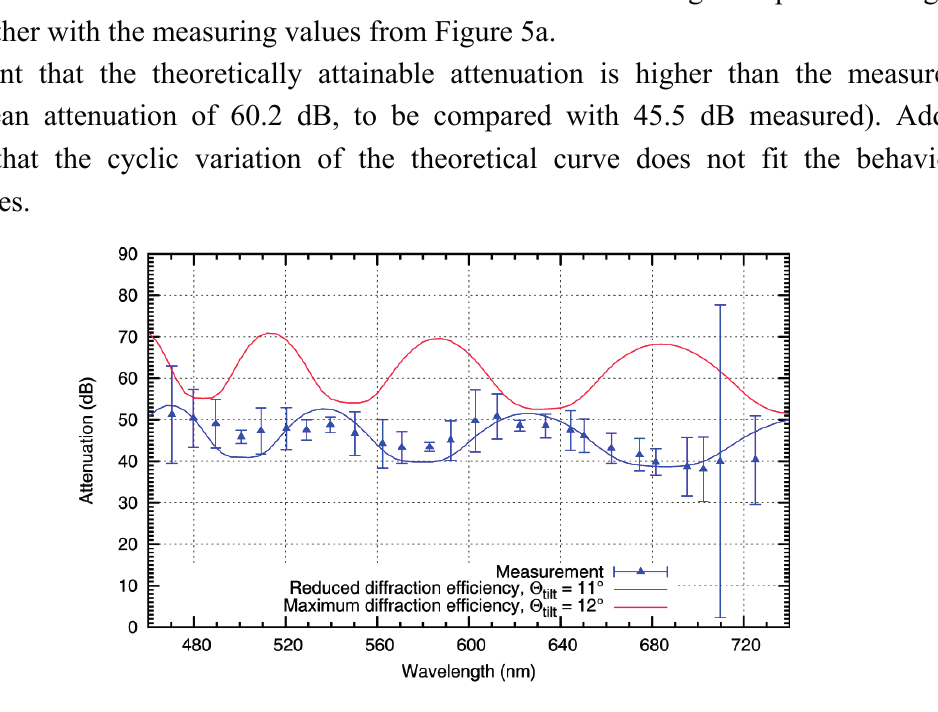
Figure 7. Comparison of the measured attenuation of monochromatic light with theoretical calculations. For ideal conditions (red curve), the maximum attainable attenuation is considerably higher than the measured values. The blue curve represents a calculation for fitted system parameters and is in good agreement with the